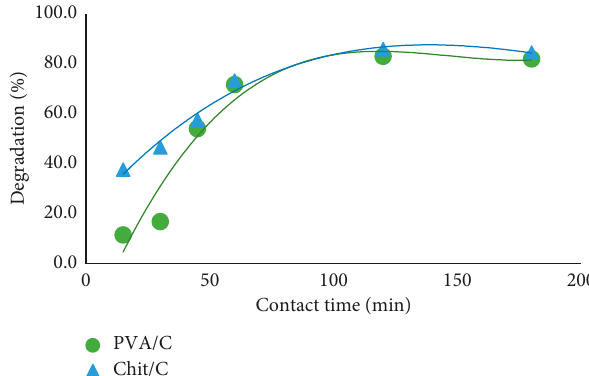
Figure 7: Percentage photodegradation as a function of contact